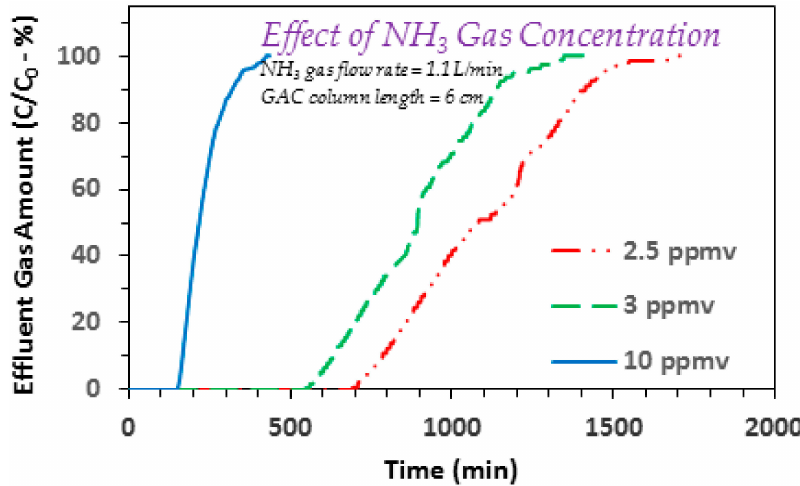
Figure 3. E ff ect of influent ammonia gas concentration on the adsorption breakthrough curve profile of ammonia gas on to GAC produced from date palm pits (GAC SSA BET = 822 m 2 / g and average pore width = 23.01 Å; ammonia / NH 3 gas flow rate = 1.1 L / min; influent ammonia / NH 3 gas concentrations 2.5, 3, and 10 ppmv; GAC column length = 6 cm; GAC bed dia. 6.35